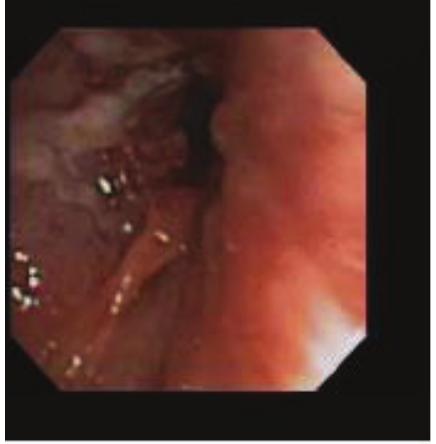
Figure 1: CT scan showing a right hilar mass which encases and narrows the right upper lobe bronchus and the right main stem bronchus.